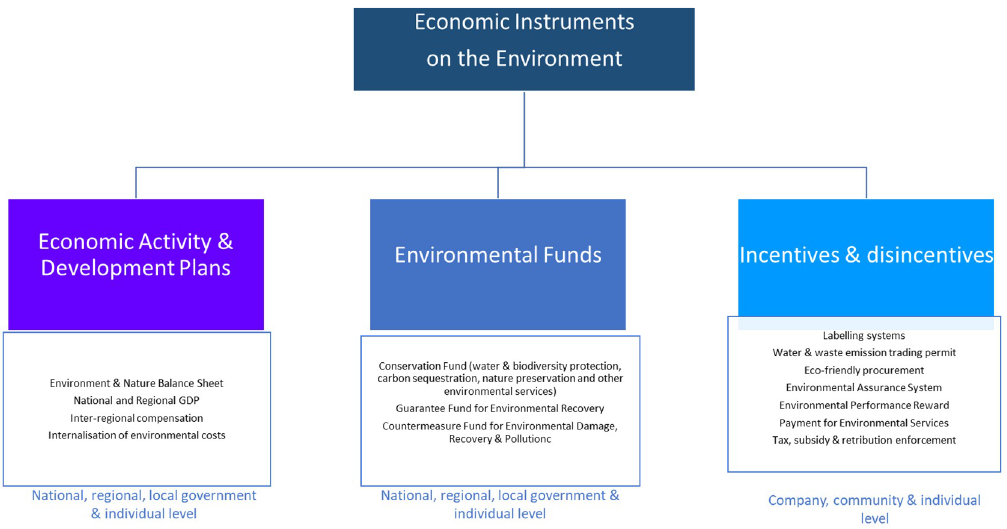
Figure 2. Visualization of Government Regulation No. 46 / 2017 on Economic Instruments on the Environment.